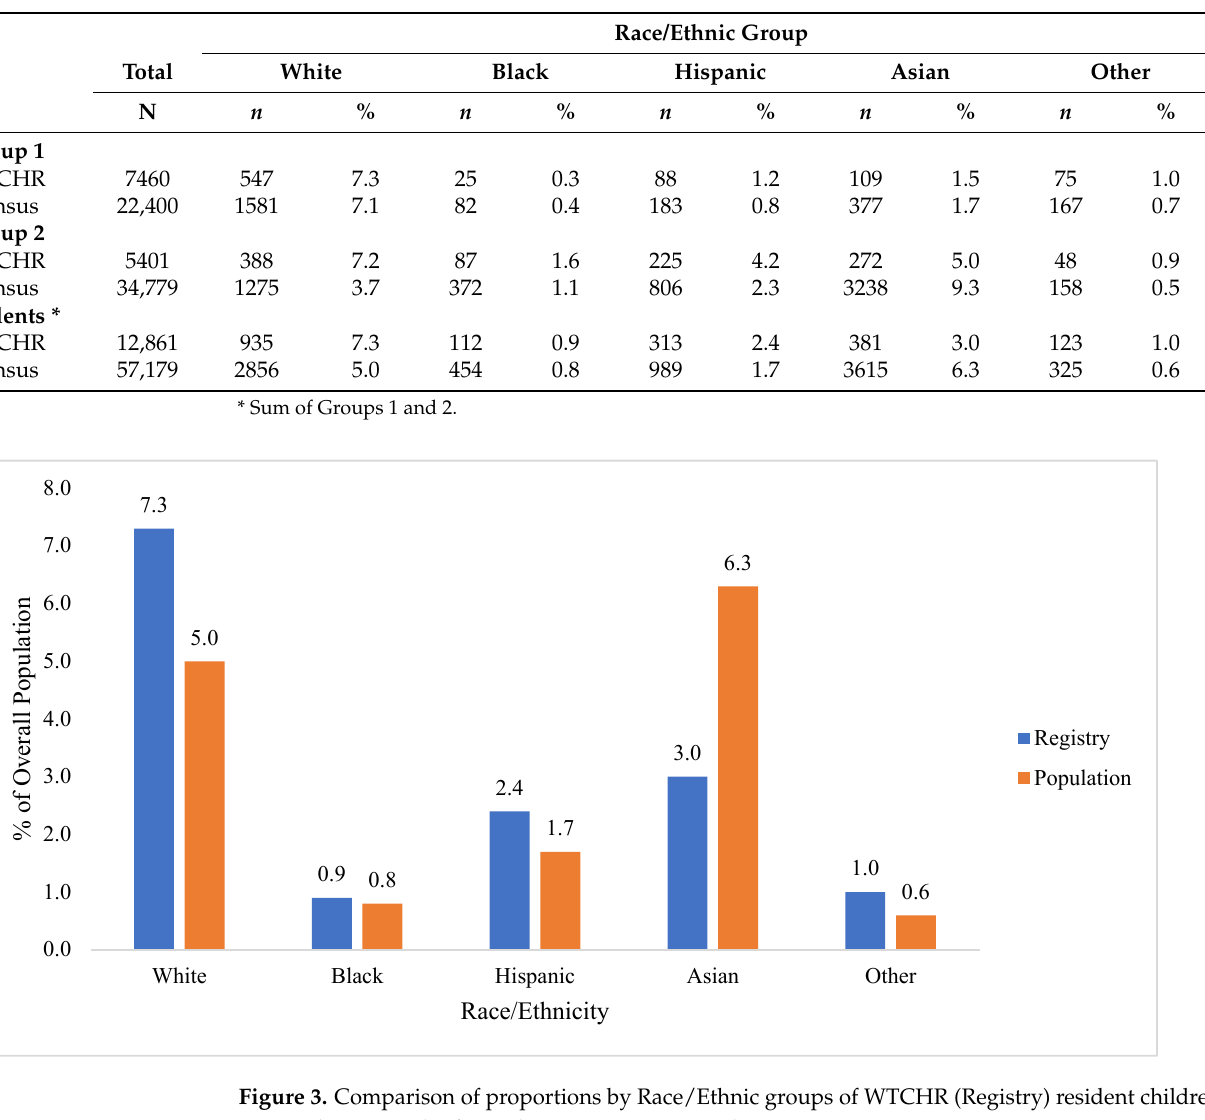
Table 4. Comparison of proportions by sex of WTCHR resident children <18 years on 11 September 2001 with 2000 census for south of Canal Street in Lower Manhattan. Denominator of proportions is Total for all residents.